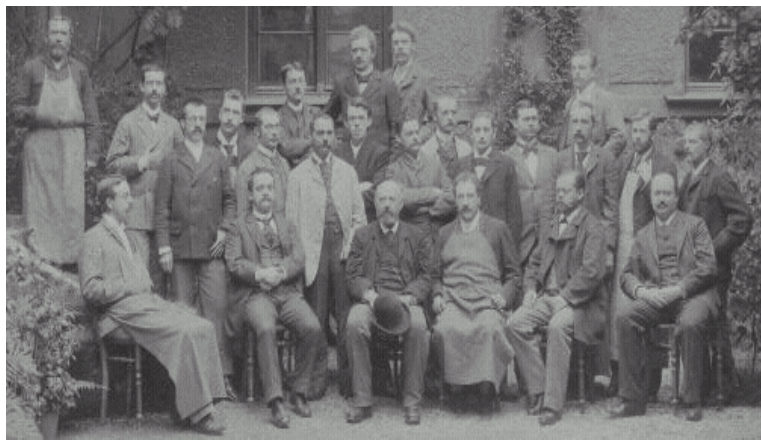
Figure 3. Adolf von Baeyer (1835–1917), discoverer of barbituric acid, in the centre with a hat in his hands, together with his team from the Chemistry Laboratory of the Munich Academy of Sciences, in 1893.